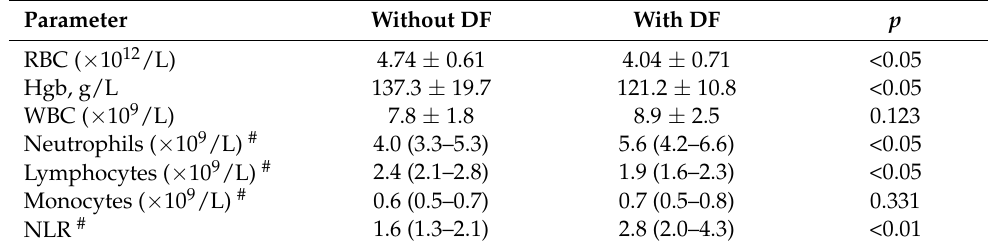
Table 2. CBC parameters and NLR index in patients without DF and with